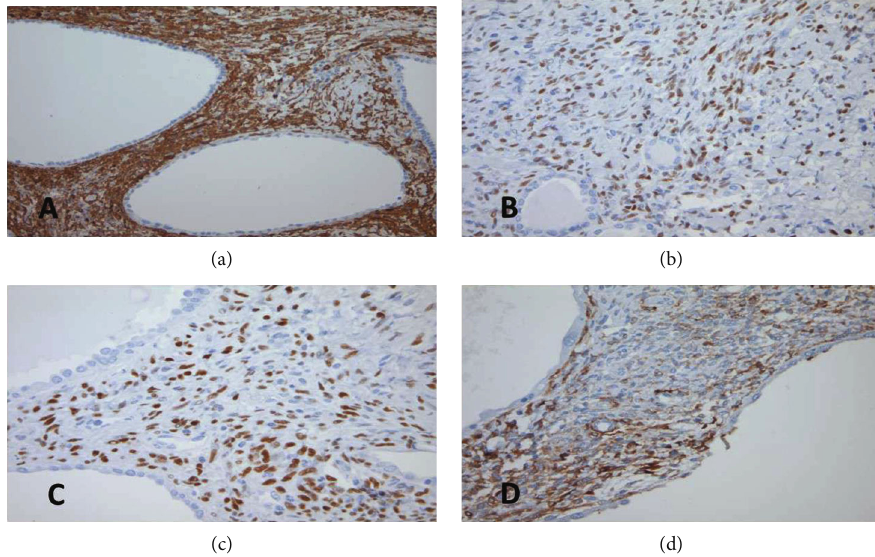
Figure 4: Immunohistochemical staining. The stroma showing positivity for (a) smooth muscle actin (SMA, 200x), (b) estrogen receptor (ER, 200x), (c) progesterone receptor (PR, 200x), and (d) CD10 (CD10,